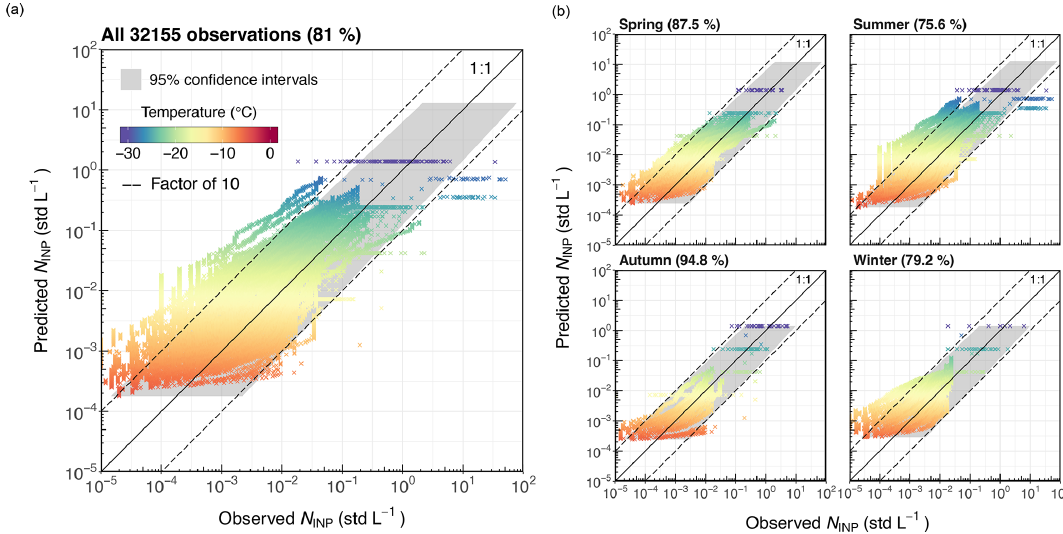
Figure 10. Predicted INP concentrations from the proposed fit (Eq. 3) compared to observations from previous Arctic field campaigns. An overview of the data used is given in Table S3 (see Supplement). (a) All 32155 observational data. (b) Data per season (season classification: spring (March–May), summer (June–August), autumn (September–November), and winter (December–February)). The 1 : 1 line and a devi- ation of factor 10 are given in solid black and dashed black, respectively. The nucleation temperature of the corresponding INP concentration is given in color. The 95% confidence interval of the fit is given in gray. The values in the parentheses represent the percentages of predicted data falling within the 95% confidence